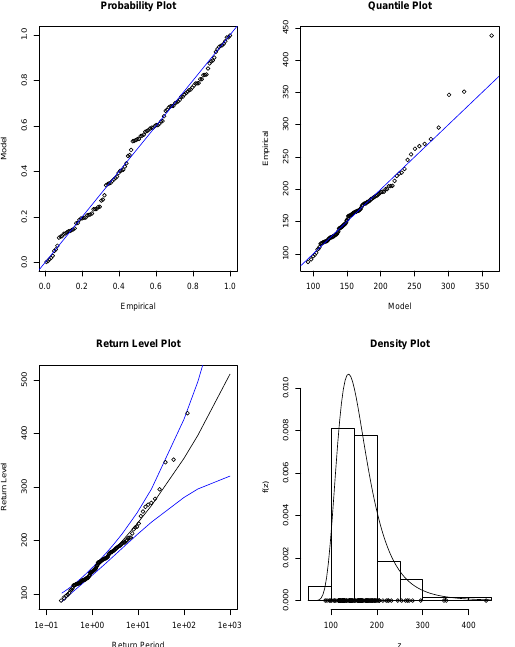
Figure 4. Diagnostic plots for the stationary GEVD best fitting model for Gauteng province. Goodness-of-fit test for Gauteng GEVD model Kolmogorov-Smirnov (K-S) and Anderson-Darling (A-D) tests were used to deter- mine whether maximum monthly rainfall data for Gauteng follow a stationary GEVD.